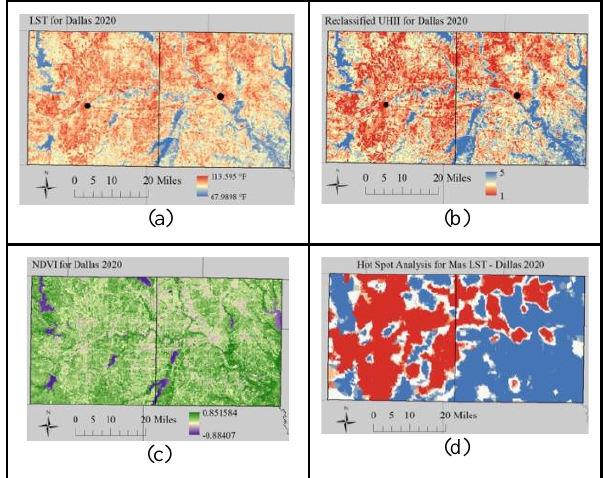
Figure 5. LST (a), UHII (b), NDVI (c), and LST hot spots (d) maps for Tarrant and Dallas Counties, TX for June 2020. The left box in each map in Figure 5 represents Tarrant County, with the center of Fort Worth indicated by the left point in